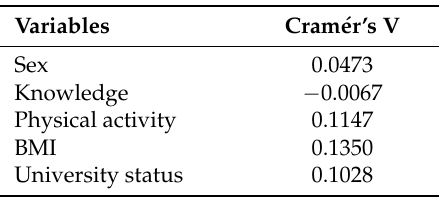
Table 4. Association between Supplement intakes with: sex, knowledge, physical activity, BMI and university